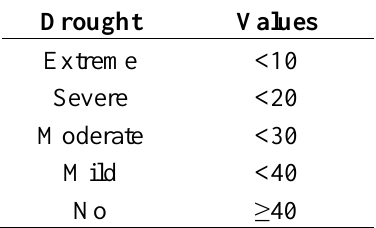
Table 4. Classification of the VCI, TCI and VHI values in term of